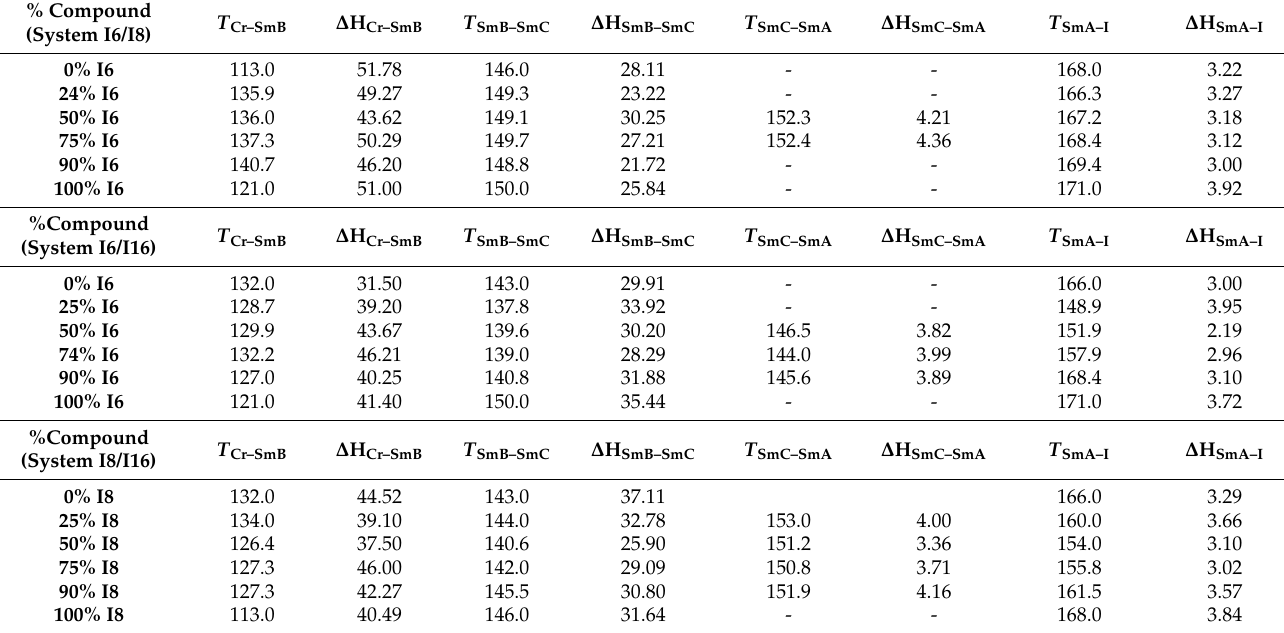
Table 1. Phase transitional temperatures ( ◦ C) and related enthalpies ∆ H, kJ/g for binary mixtures.